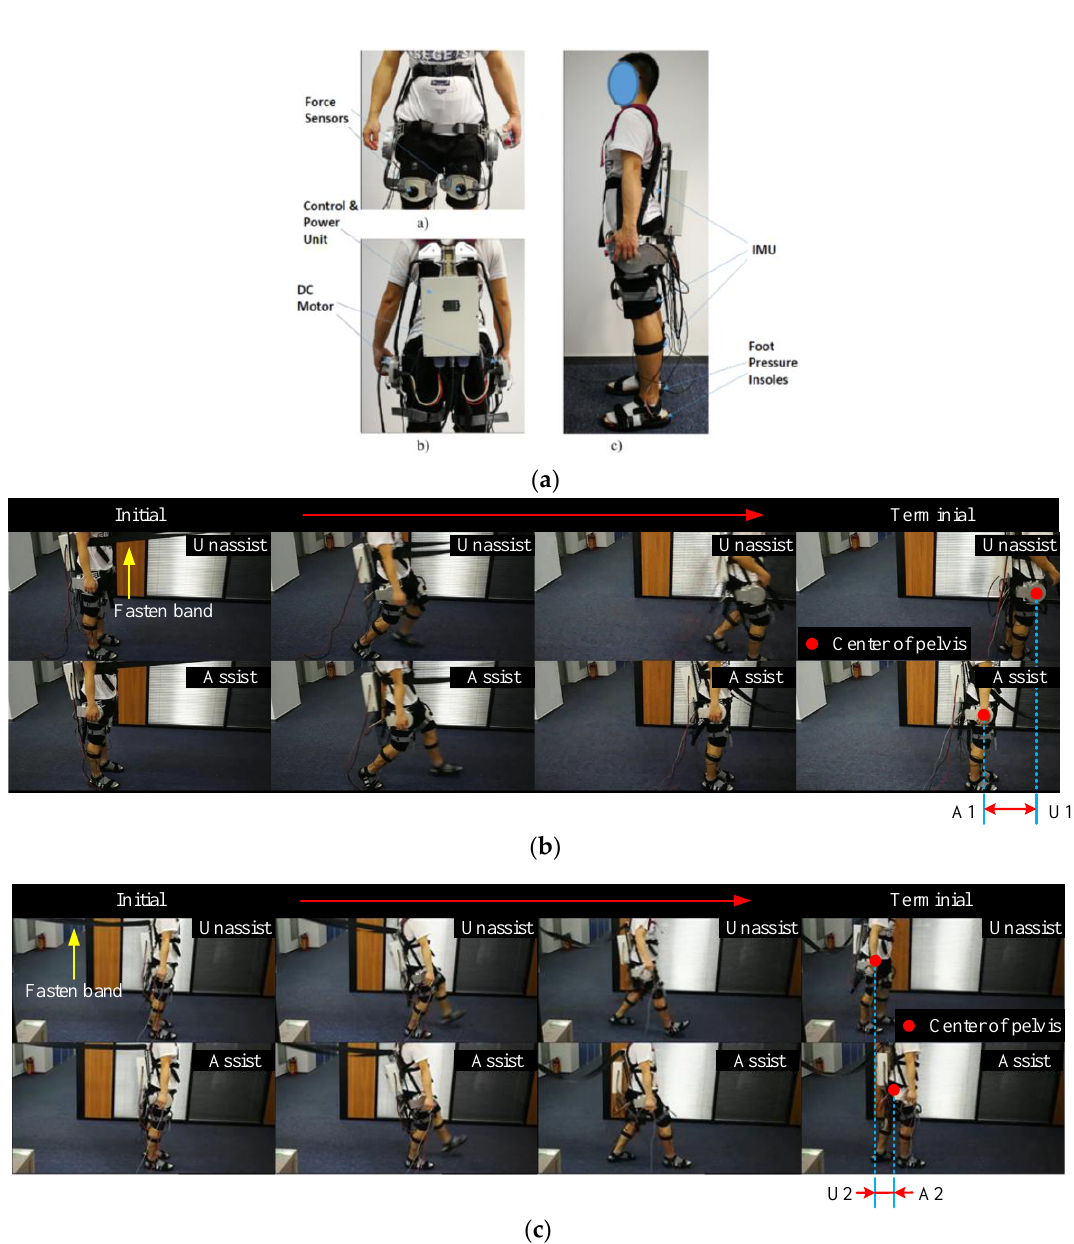
Figure 13. Hip assist exoskeleton (HAE) for gait and balance assistance: ( a ) The sensors and actuators of the exoskeleton; ( b ) The experiment environment of forward pulling; ( c ) The experiment environment of backward pulling.